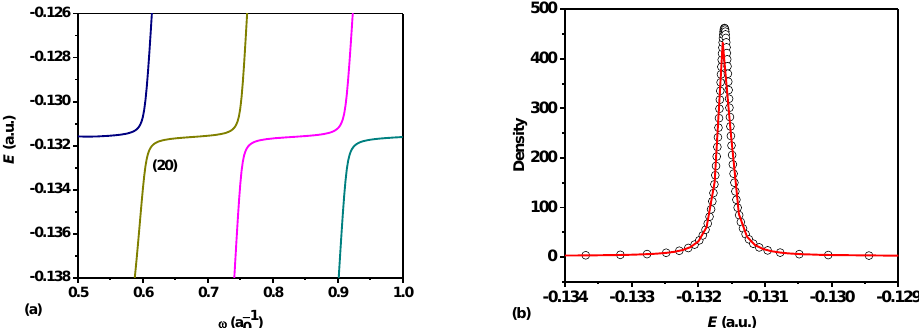
Figure 2. ( a ) Stabilization diagram for the 3 P o (1) state of π − for λ = 0.01 (the number 20 in the diagram indicates the 20th energy level). ( b ) Calculated densities (circles) and Lorentzian fits (solid line and the best fit) for the 3 P o (1) state of π − for λ = 0.01 .